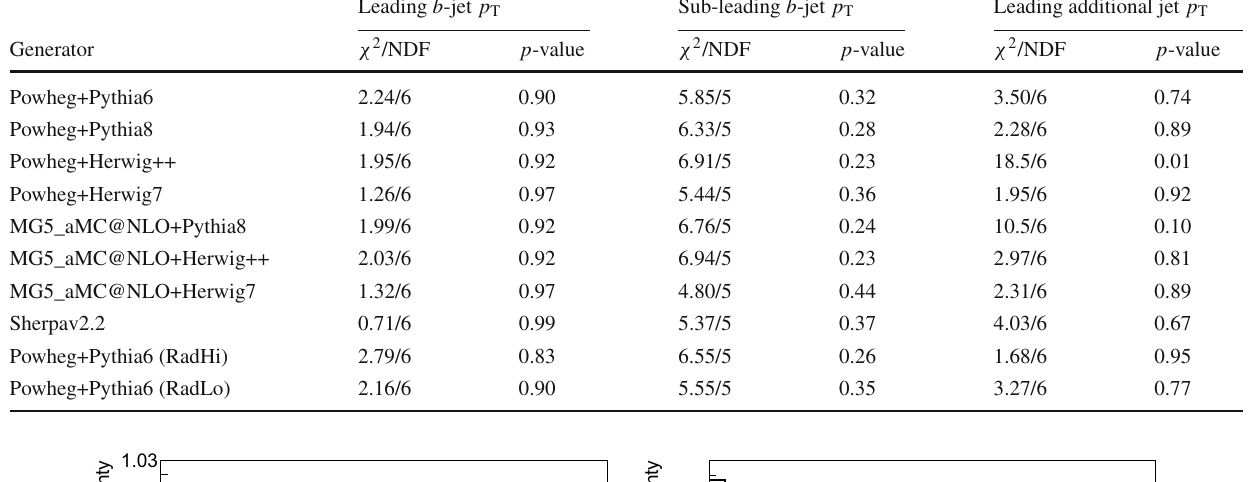
Table 10 Values of χ 2 / NDF and p -values between the unfolded normalised cross-section and the predictions for the jet p T measurements. The number of degrees of freedom is equal to one less than the number of bins in the distribution